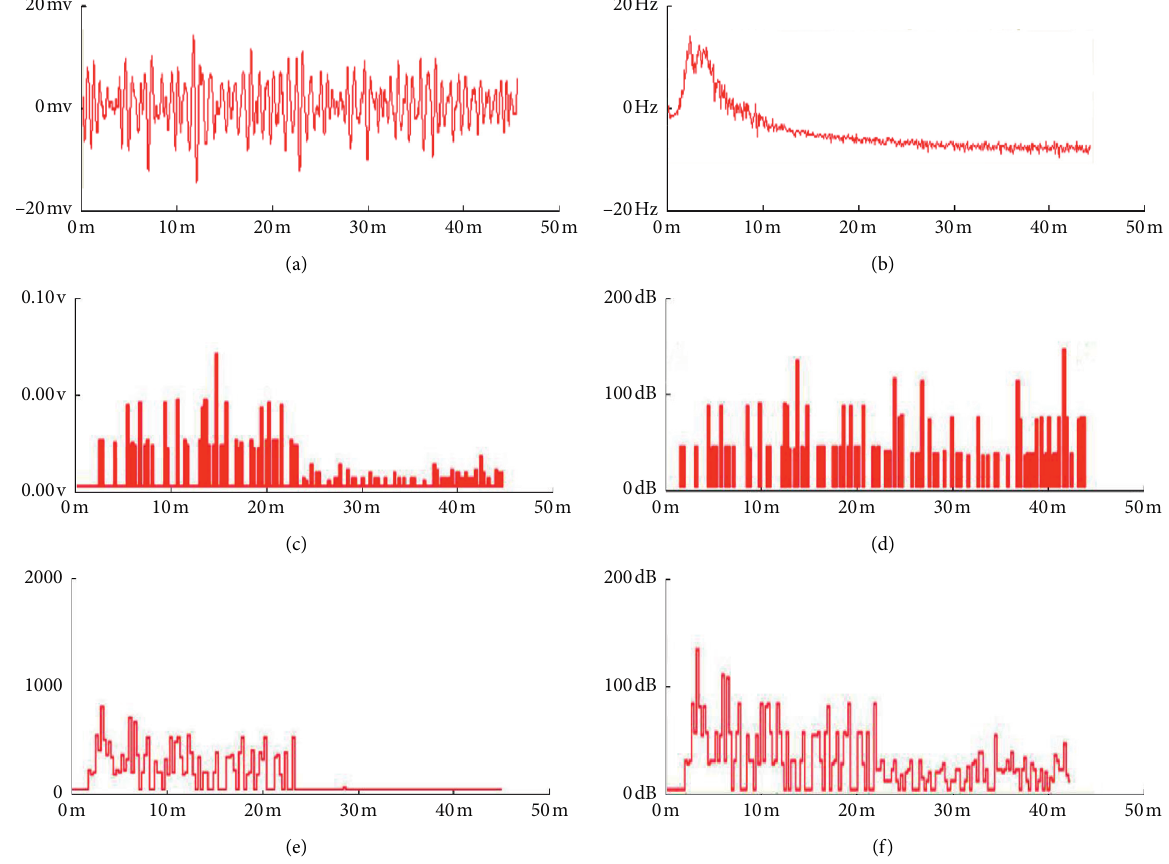
Figure 4: The result of using acoustic emission to deal with multisource leakage: (a) waveform of the initial positioning signal; (b) spectrum of the initial location signal; (c) RMS of the initial positioning signal; (d) amplitude of the initial positioning signal; (e) energy map of the initial positioning signal; (f) ASL of the initial positioning